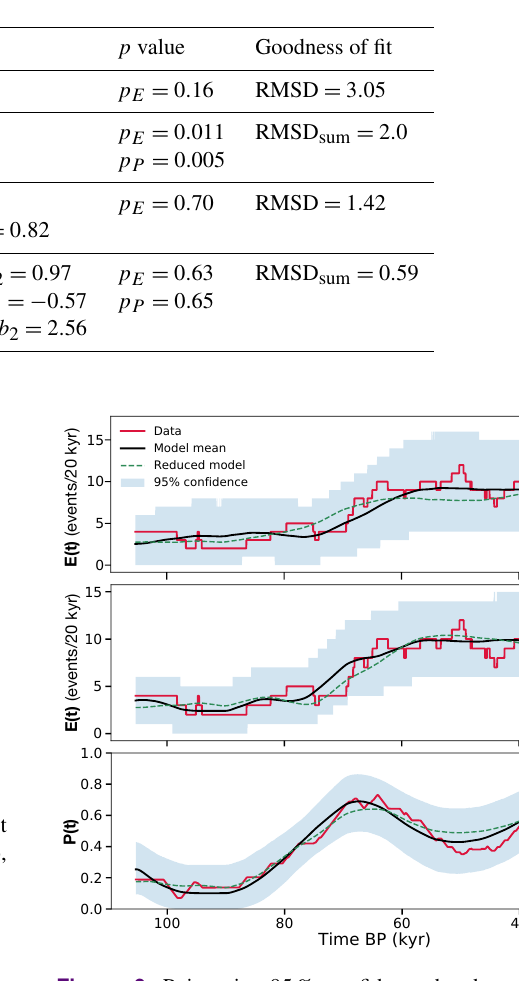
Figure 6. Point-wise 95% confidence bands and model mean (black curve) for the time-varying indicators E ( t ) and P ( t ) from Monte Carlo simulations. (a) E ( t ) for the best-fit non-stationary one-process model with full forcing. (b) E ( t ) and (c) P ( t ) for the best-fit non-stationary two-process model with full forcing. The in- dicators for the data are shown in red. The green dashed line indi- cates the best-fit model mean curves for the respective models with reduced forcing, as described in the main